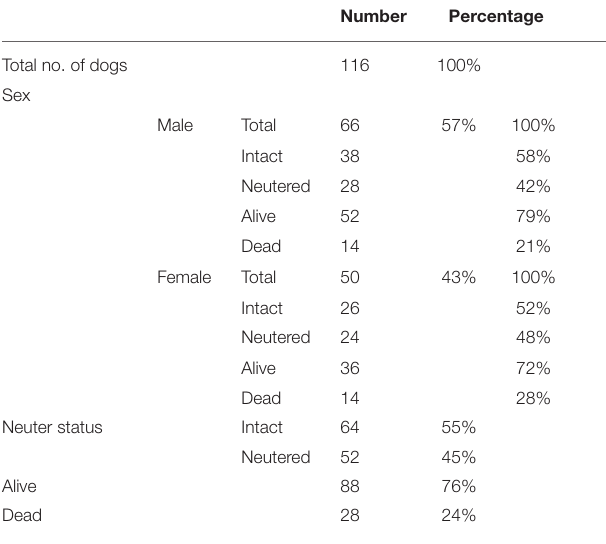
TABLE 1 | Study population characteristics.